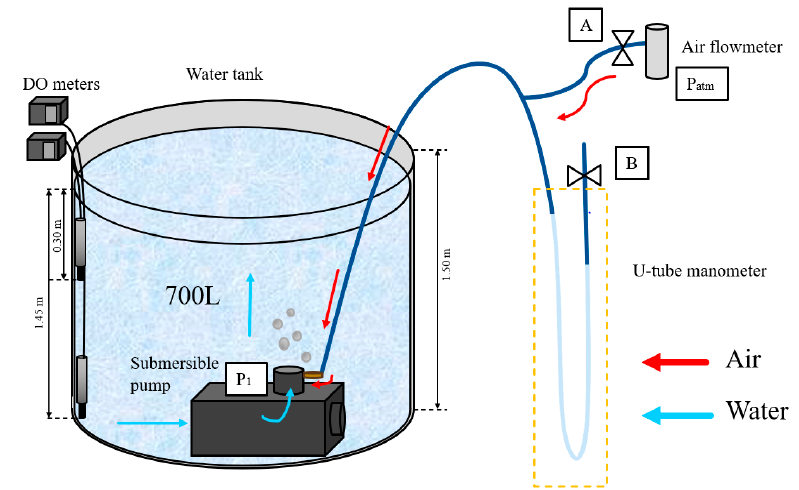
Figure 1. Illustration of experimental setup, in which P 1 is the vacuum pressure measured using the water manometer, while A and B are valves to adjust the velocities.